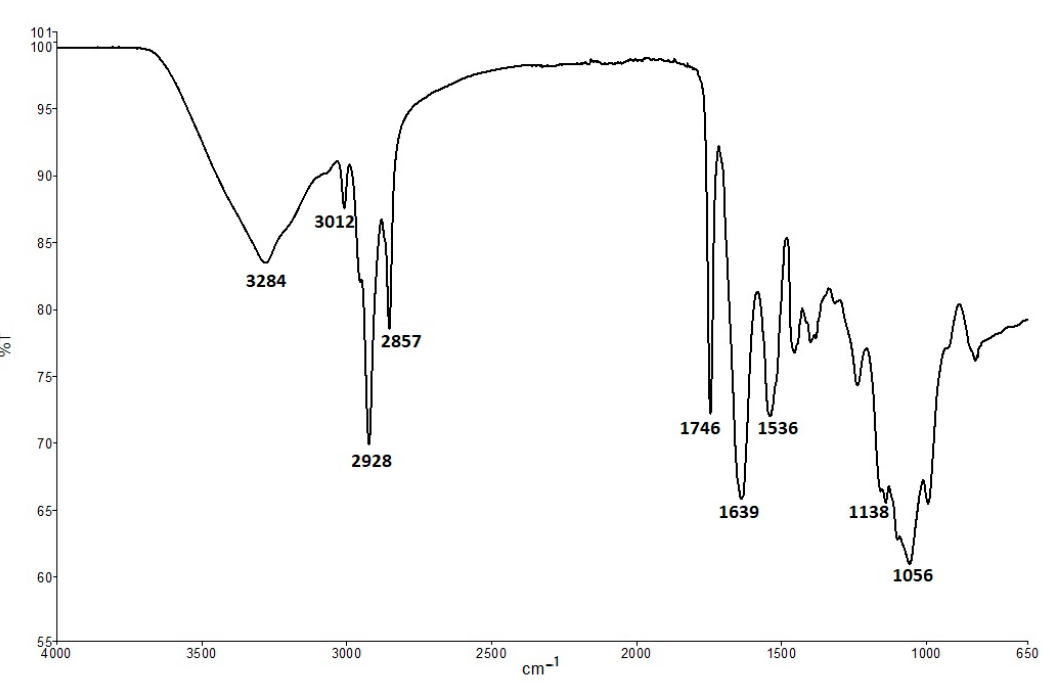
Figure 2. Representative ATR-FTIR absorption spectra in the region 4000–650 cm − 1 , with the absorptions of principal functional groups, of seeds from hemp plants fertilized by ammonium nitrate (NH 4 NO 3 ) and urea. CTR, control seeds. %T indicates the amount of light that passes through the sample.